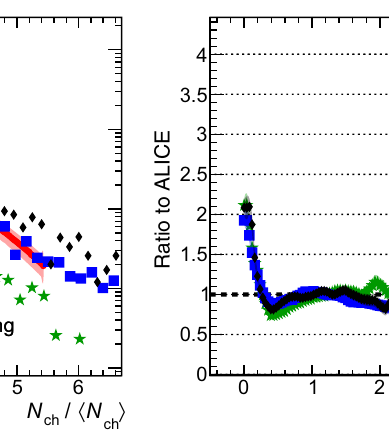
stars), allowed to fluctuate with a Gaussian (blue squares) [12] or with additional fluctuations of proton saturation scale (black diamonds)